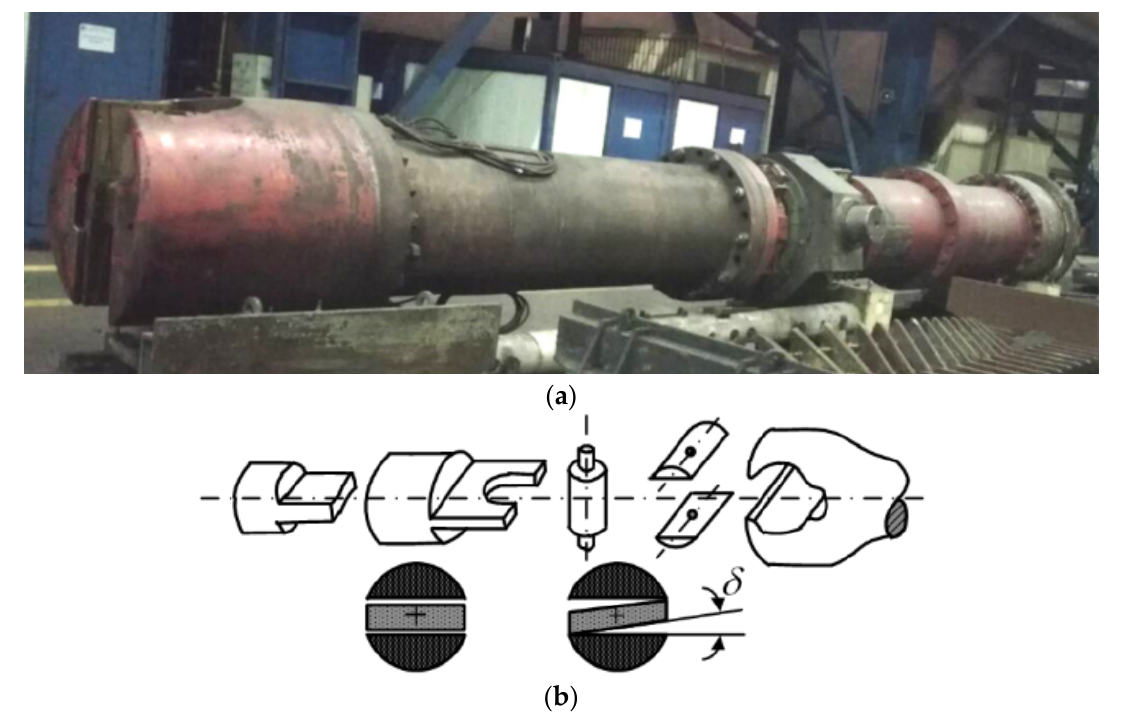
Figure 3. The spindle image ( a ) and the spindle joint ( b ) design of the Mill 5000 horizontal stand. If the angular gap δ is open, then it closes during the biting with a mechanical impact and elastic oscillations in the spindle. In the newly installed mechanism, the joint gap is